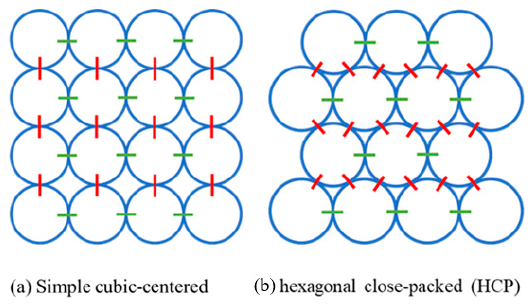
Figure 2. Two different types of the model structure used in DEM modelling (2D view).